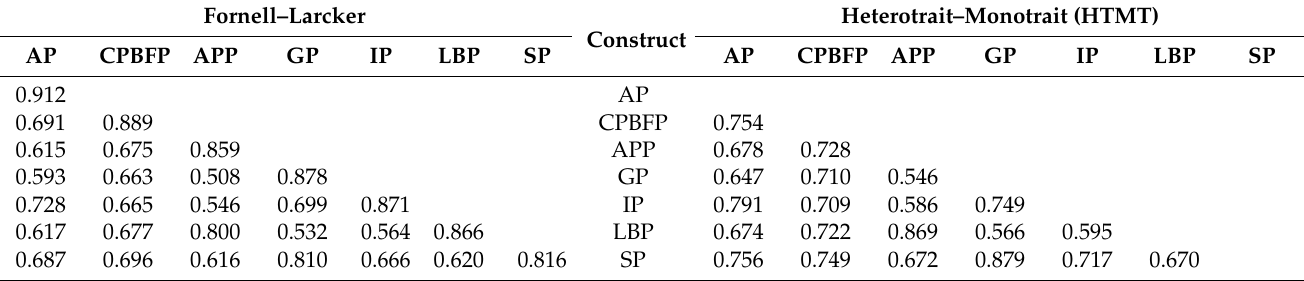
Table 2. Discriminant validity